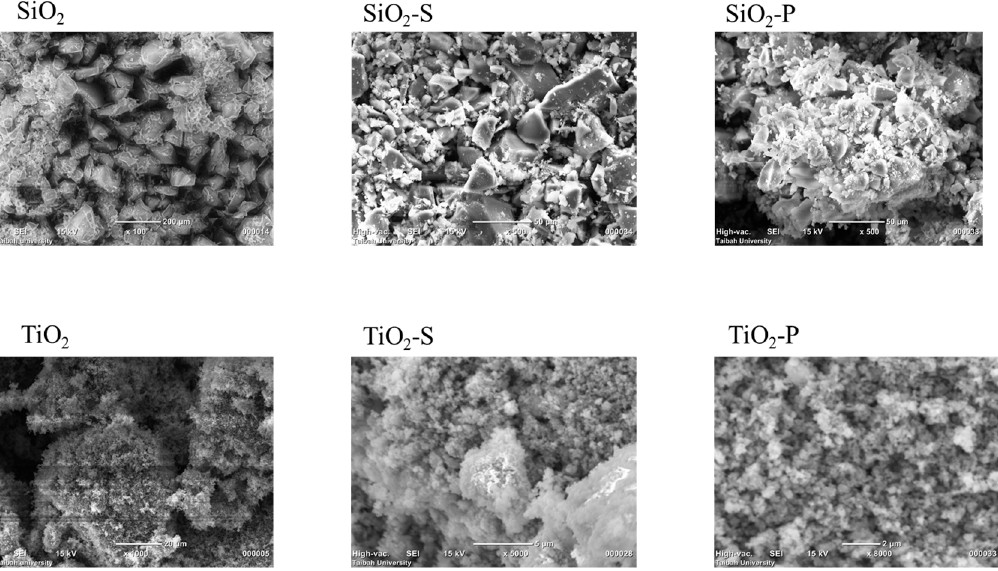
Figure 2. SEM microphotograph of silica, sulfated silica, phosphated silica, titania, sulfated titania, and phosphated titania.